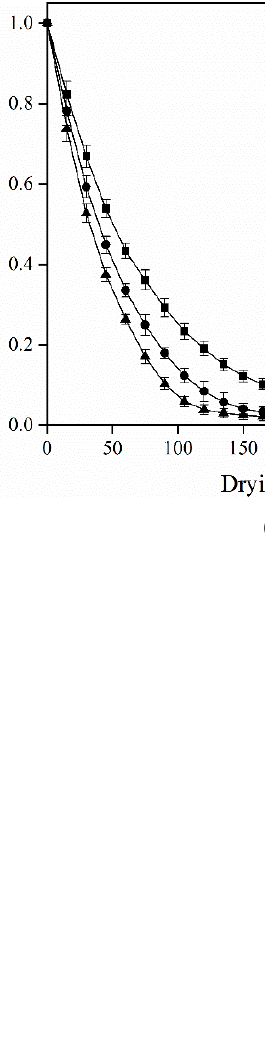
Table 2. Parameter values and statistical results of the thin layer drying